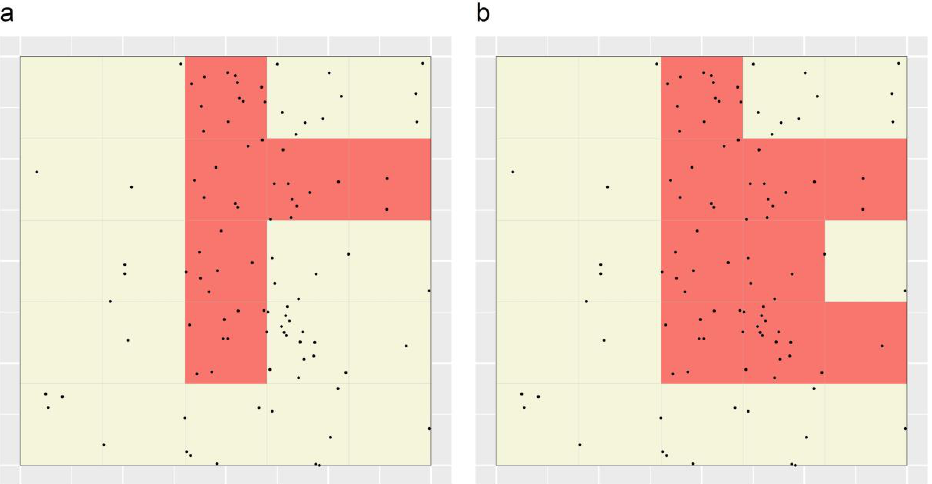
Figure 4. TRs delienated through applying the STA to the simulated dataset represented in Figures 2 and 3, either ( a ) with splitting or ( b ) without splitting, based on a target case percent- age of 40% of cases. Black dots depict the locations of simulated cases, grid lines represent the set of minimal units specified for the STA and the red-shaded regions represent